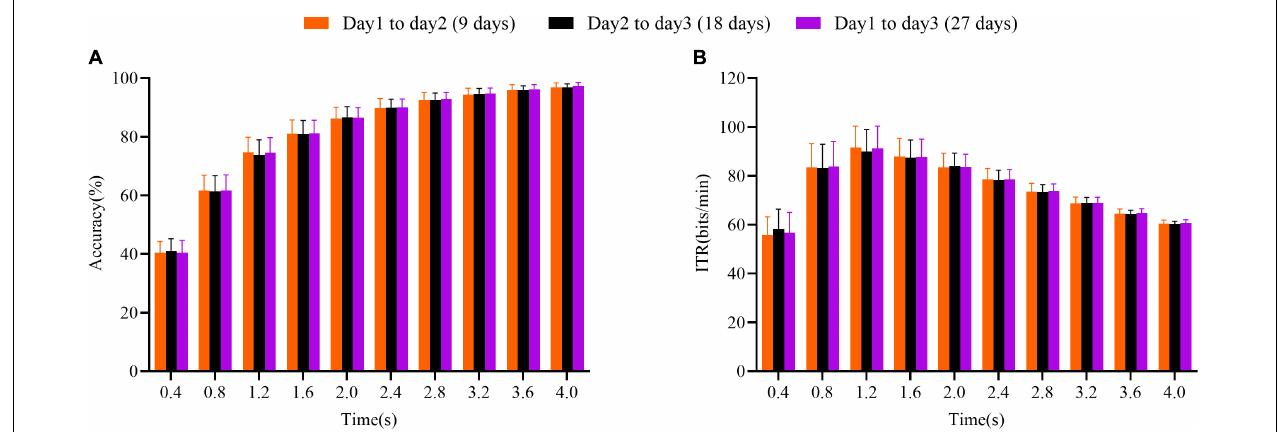
FIGURE 7 | The influence of the number of days between experiments on the ALPHA performance. (A) Accuracy. (B) ITR value. The presented results denote the average results of the mutual transfer between two days. The error bars indicate standard errors.